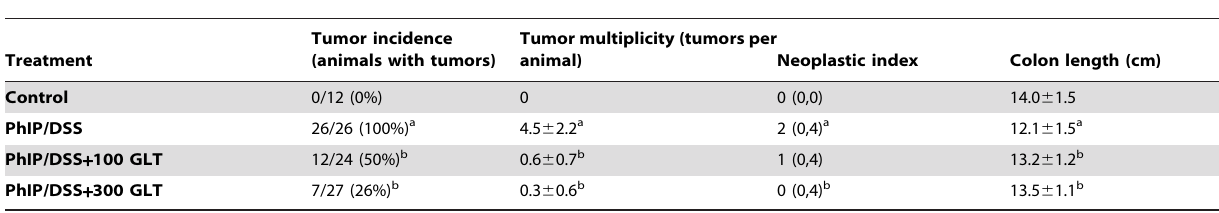
Table 5. Chemopreventive effect of GLT on the PhIP/DSS induced colon carcinogenesis and inflammation.